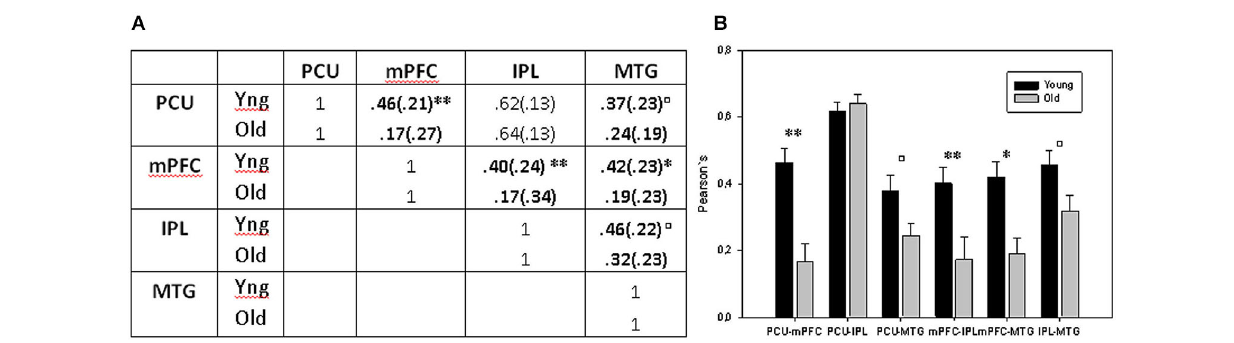
FIGURE 3 | (A) Mean correlations between DMN ROIs. (B) Bar charts displaying mean connectivity between DMN ROIs in both old and young groups. ** = p < 0.01 and * = p < 0.05 after Bonferroni correction; (cid:3) = p < 0.05 before Bonferroni correction but no longer significant when multiple comparison were